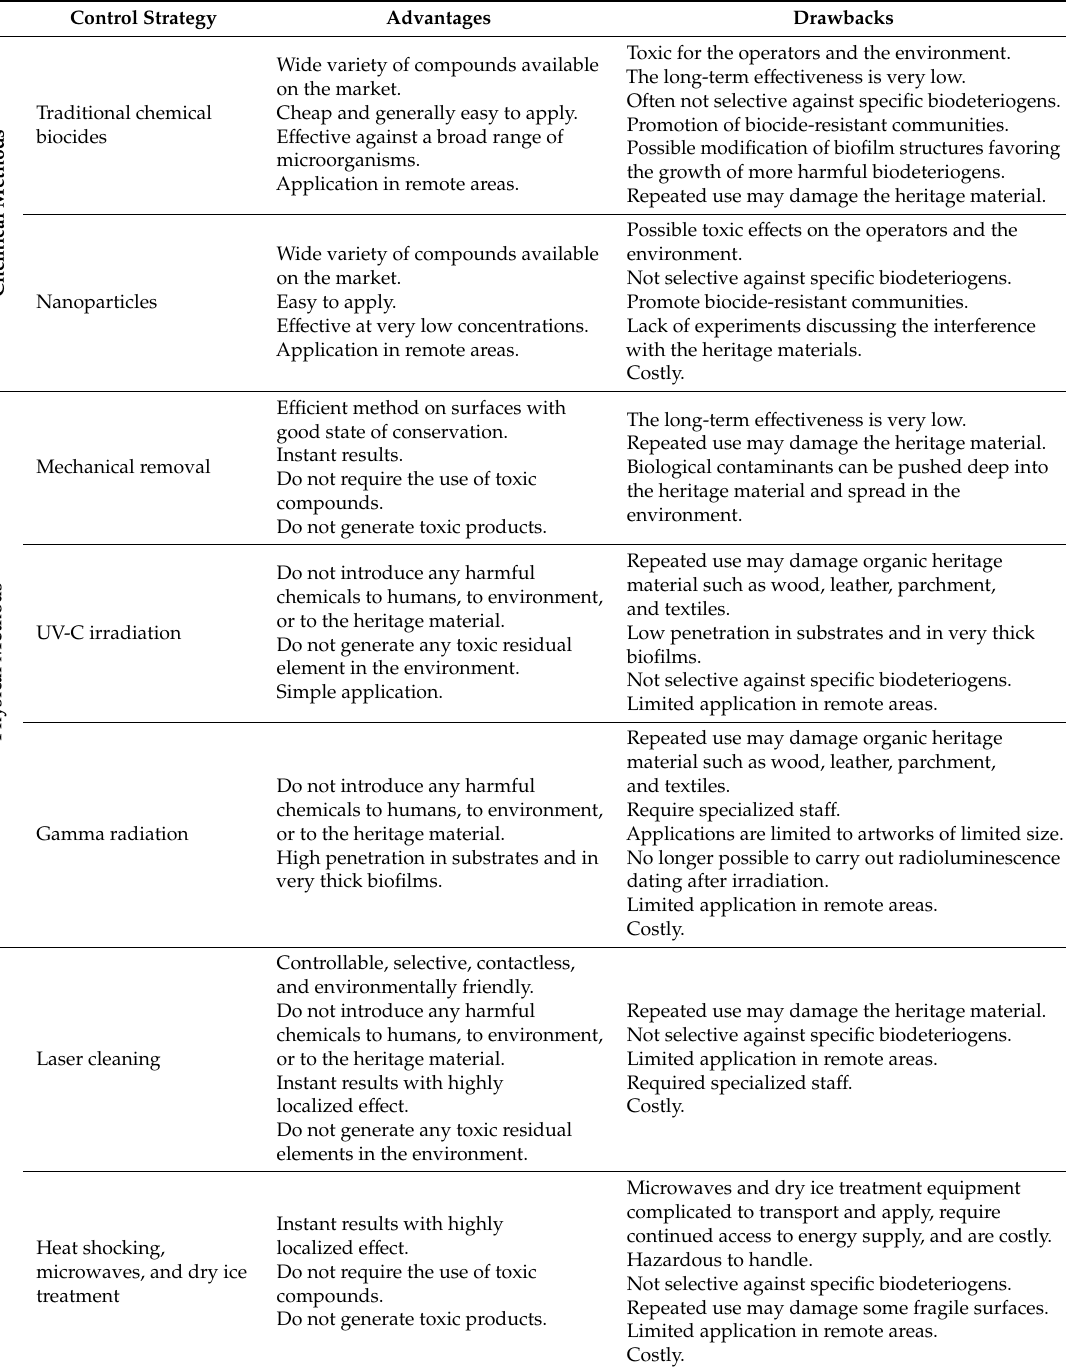
Table 1. Advantages and drawbacks of the principal control